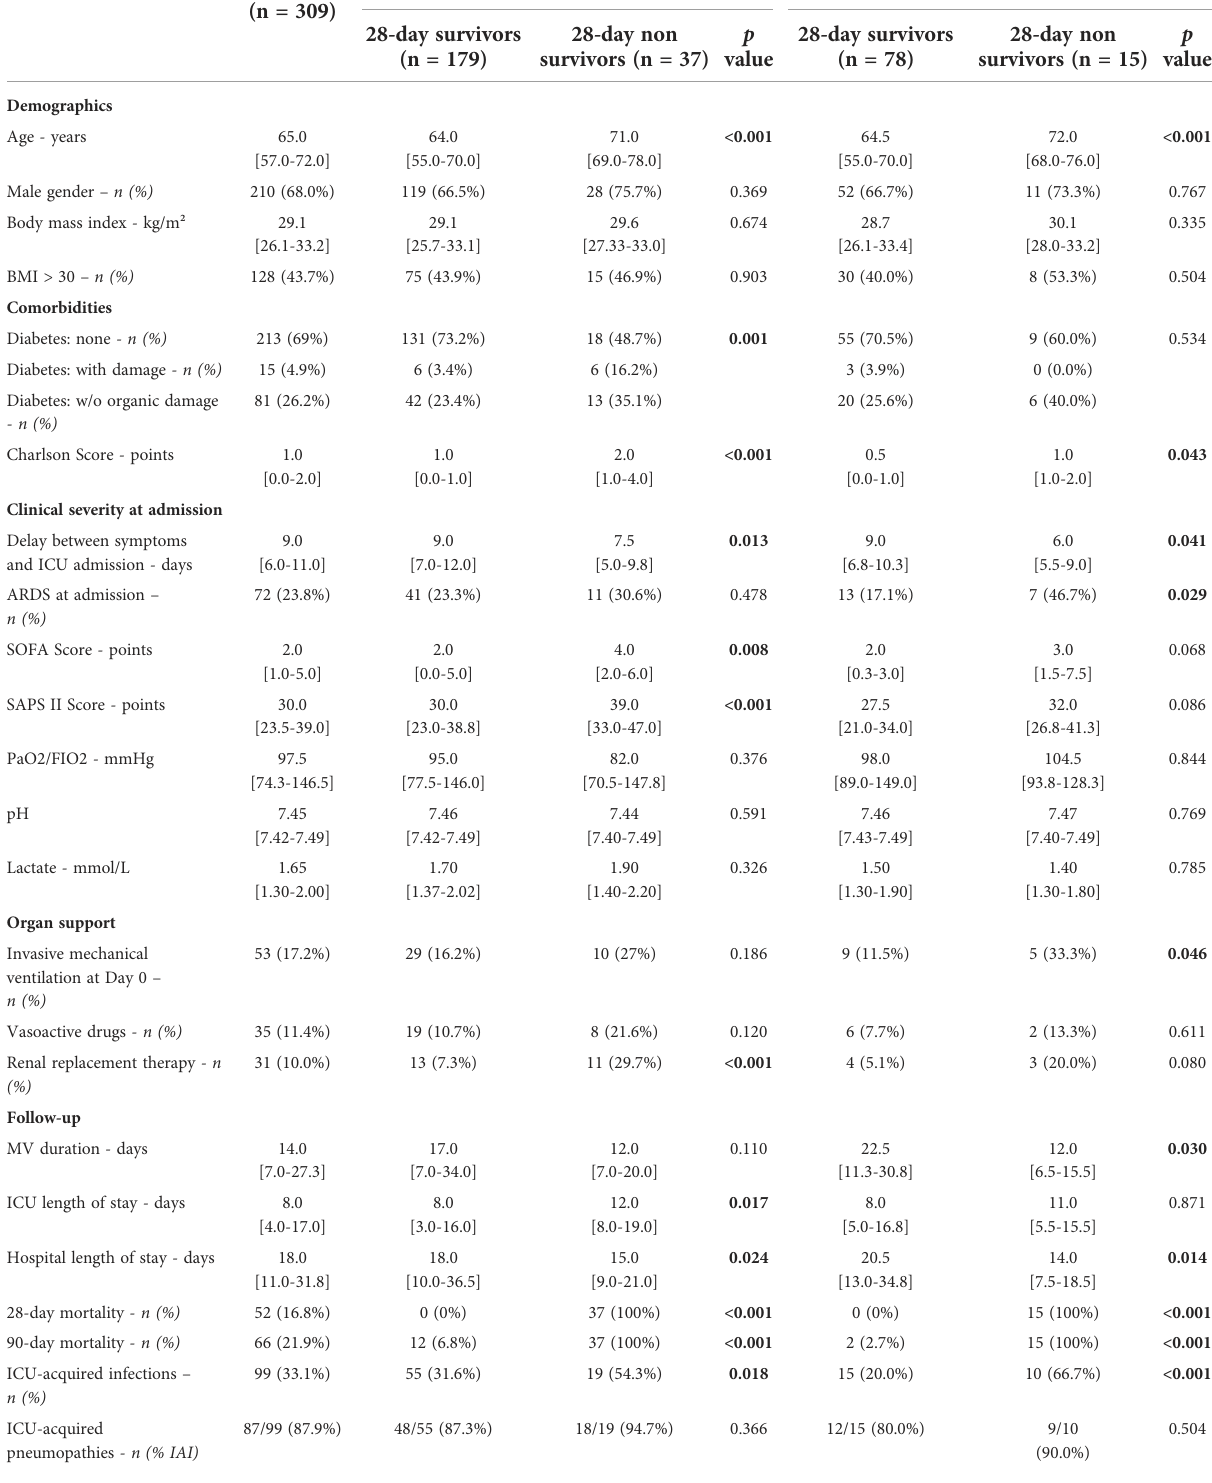
TABLE 1 Clinical characteristics of critically ill patients with